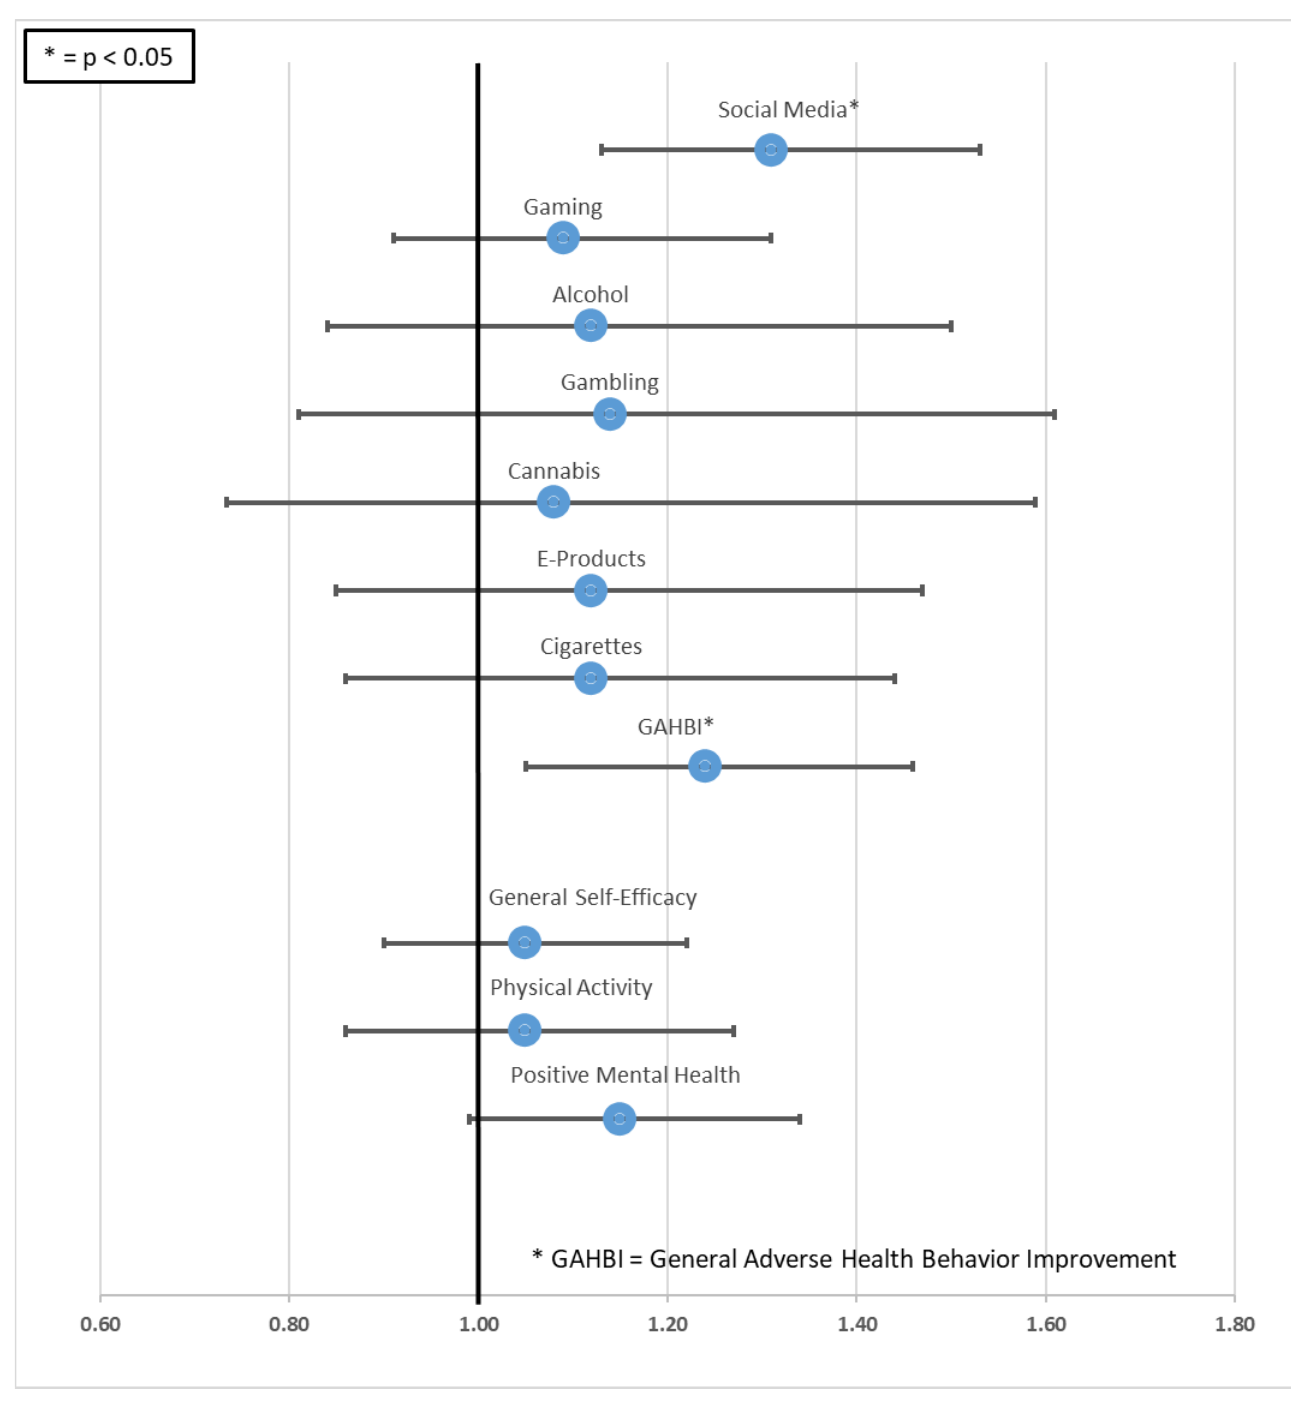
Figure 2. Change in IG participants’ behavior compared to the control group (odds ratios adjusted for highest education with 95% CI).